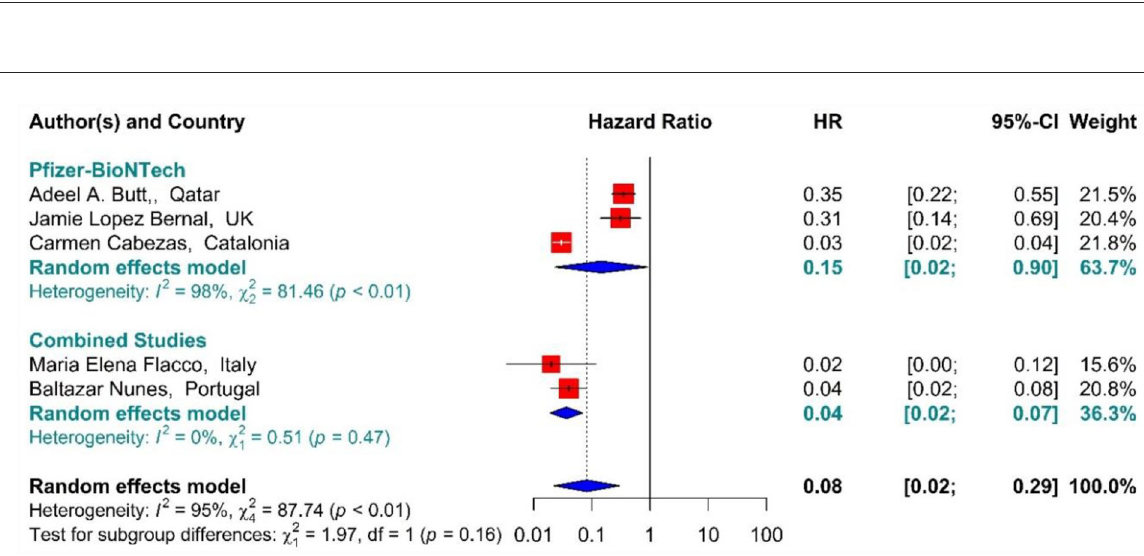
associated with 21% decrease in the risk of COVID-19 mortality compared to the first dose (68% in the first vs. 89% in the second